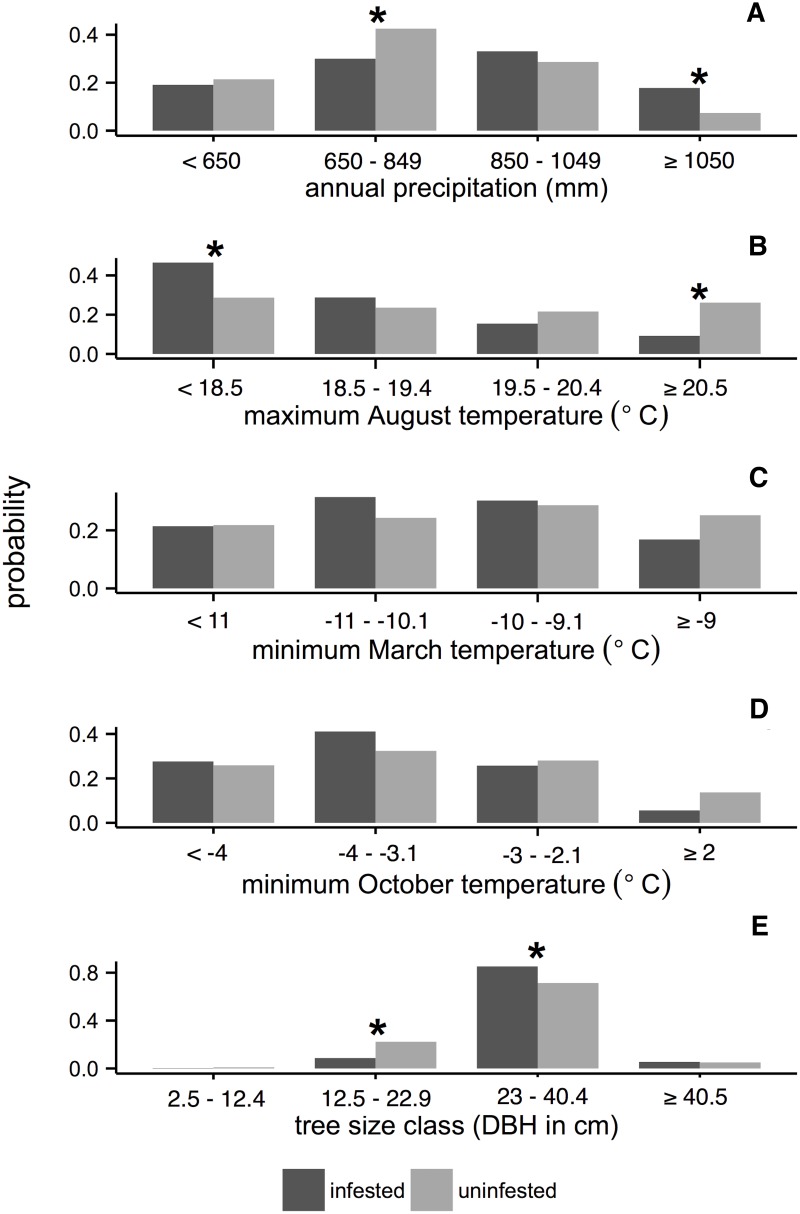
Conditional probabilities of the presence/absence of spruce beetle infestation (1997–2012) given selected bioclimatic variables in the Southern Rocky Mountains study region.(A) annual precipitation, (B) maximum August temperature, (C) minimum March temperature, (D) minimum October temperature, and (E) tree size class for uninfested and infested stands. Dark gray bars indicate conditional probability of spruce beetle infestation given that value of a bioclimate variable across the Southern Rocky Mountain study region. Light gray bars indicate the conditional probability of uninfested forest. The asterisk symbol (*) above a pair of bars indicates a meaningful difference between conditional probability of uninfested and infested forest (i.e. difference > 10%, see
Methods
 for more description). Note y-axes extend over different ranges.